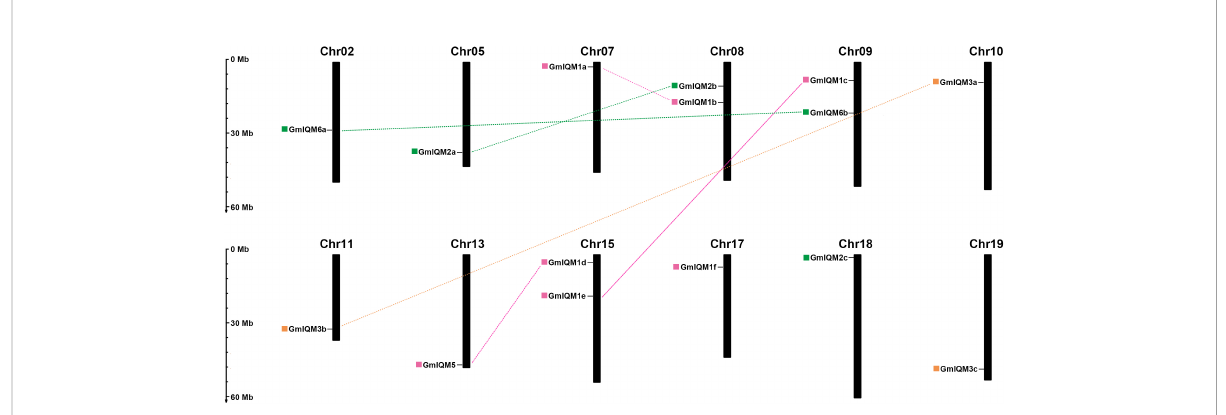
FIGURE 4 Chromosomal locations and segmental duplication of soybean IQM genes.The fi fteen IQM genes are widely mapped to 12 of the 20 chromosomes in soybean. Chromosome numbers are located at the top of each vertical bar. The duplicated paralogous pairs of GmIQM gene are connected with dotted lines of the same color. The colored boxes in front of the gene names represent different subfamilies (pink, subfamily I; green, subfamily II; orange, subfamily III). Scale on the left represents the chromosome length.